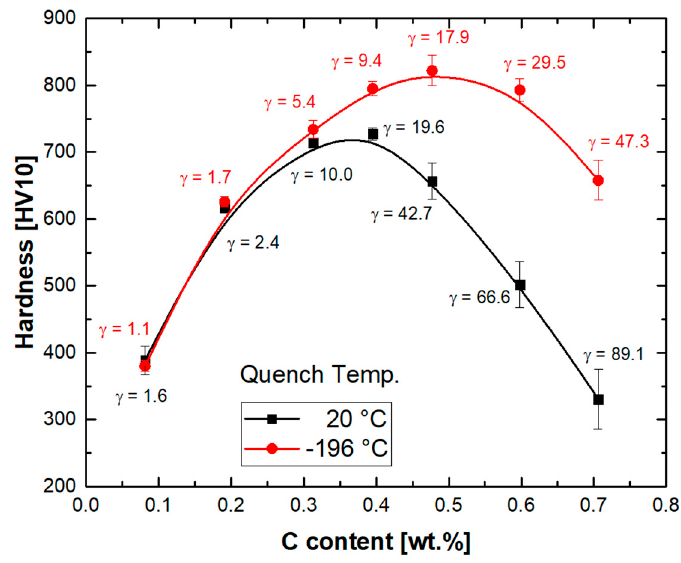
Figure 12. Vickers hardness values vs. carbon content for steels quenched to two different temperatures as marked. Number next to each symbol indicates austenite fraction in vol.%. Except for the 0.1C alloy whose microstructure consisted of martensite, ferrite, and austenite, the rest of alloys had two-phase martensitic–austenitic microstructures.